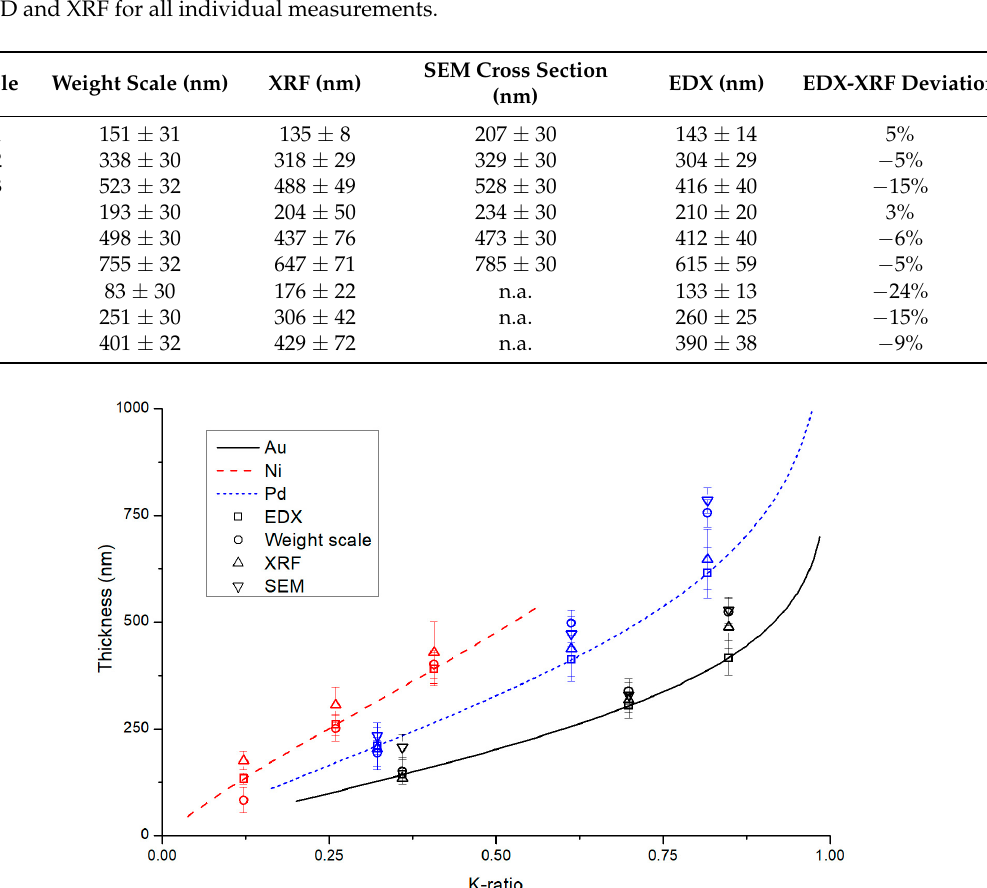
Figure 4. Metal thickness (nm) deposited on samples measured with weight scale, XRF, SEM cross section and EDX (BICS/DTSA2 simulations results) with error bars. The calibration curves (inverse function) are overlapped.